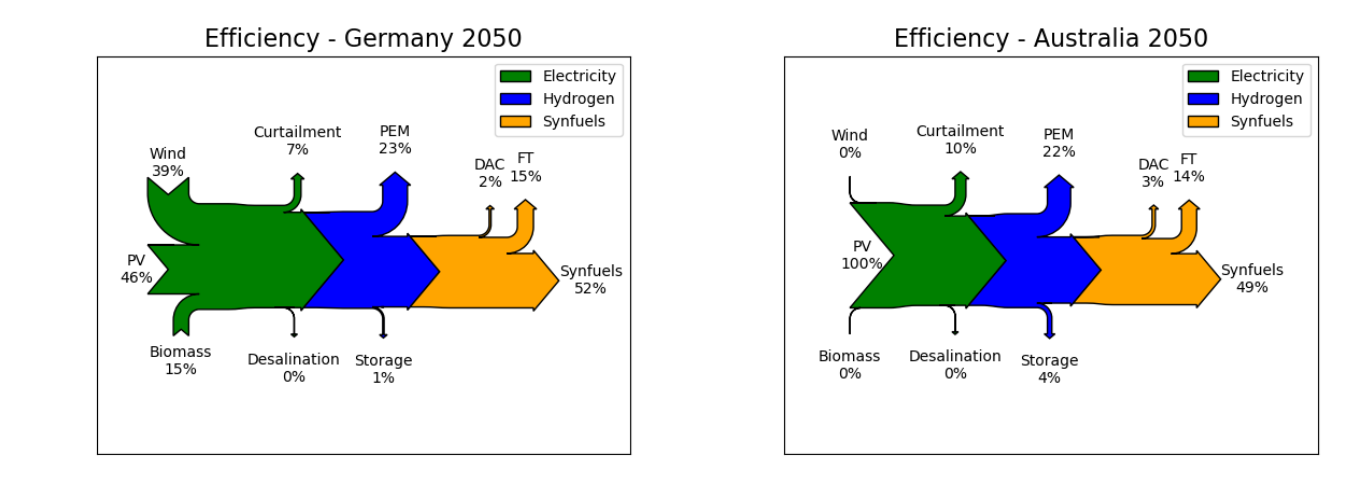
Figure 6. Energy flows for Germany and Australia in